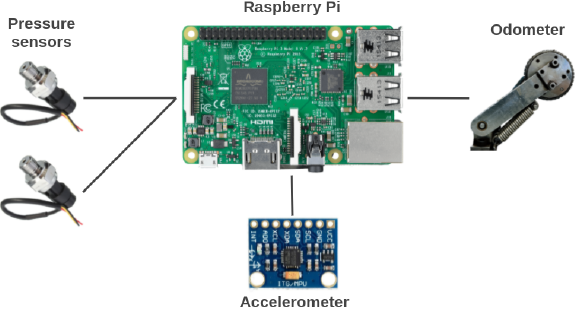
Figure 19. An overall representation of the embedded system’s elements.